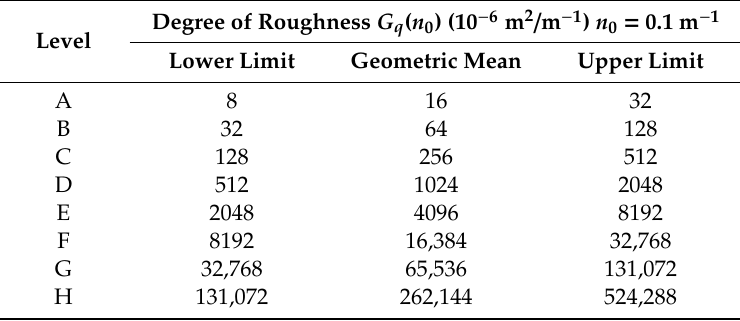
Table 2. Classification standard of road levels A–H.